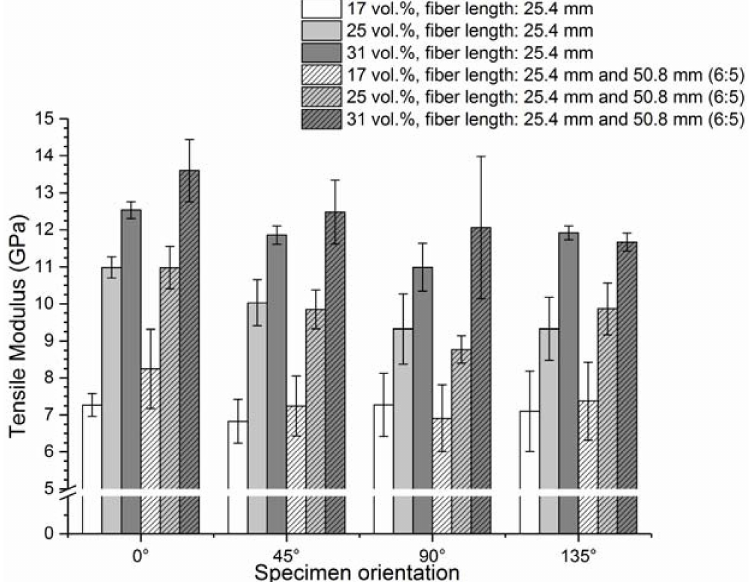
Figure 2. Tensile modulus of different SMC materials in different directions with respect to the movement of the conveyor